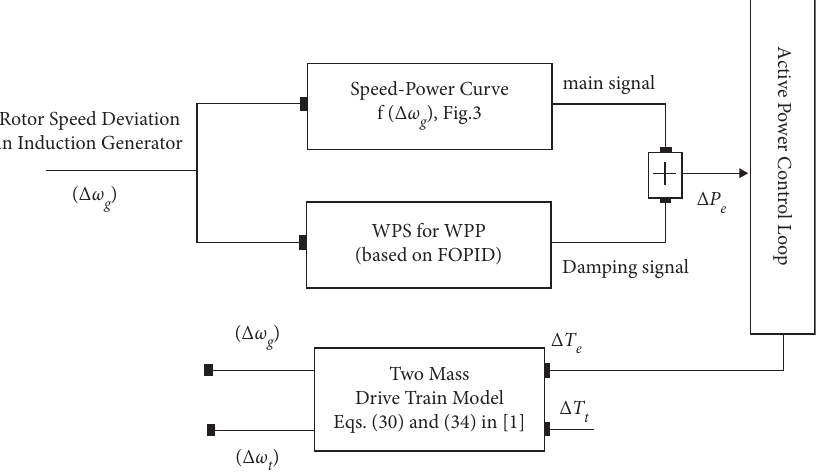
Figure 5: The proposed WPS for the drive train of the